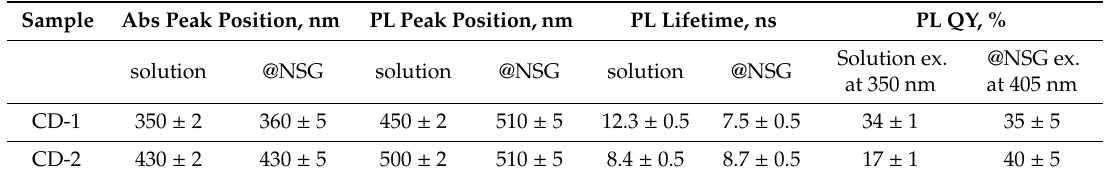
Table 1. Optical parameters of CD-1 and CD-2 samples in solution and in NSG.